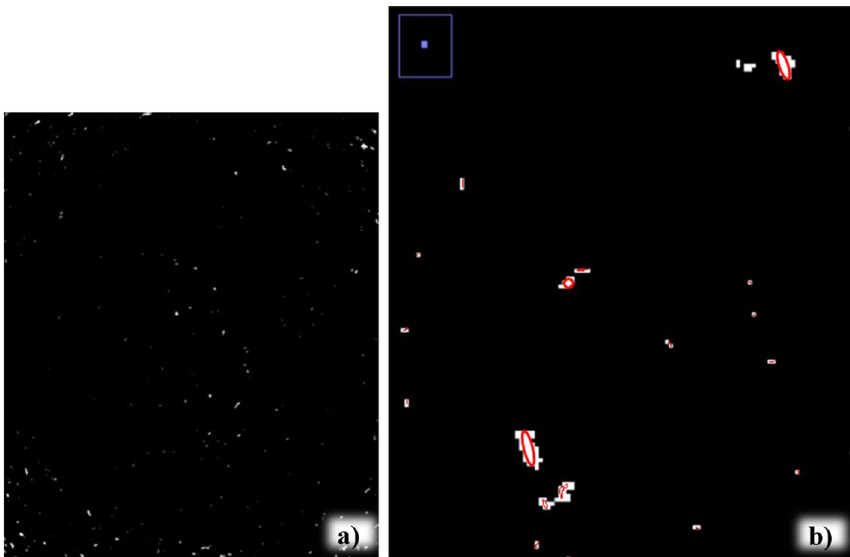
Figure 6. Representation of ellipses for the morphological analysis of each pore. ( a ) Image of the sample with binarization and ( b ) enlarged image to better visualize the ellipses in the pores.